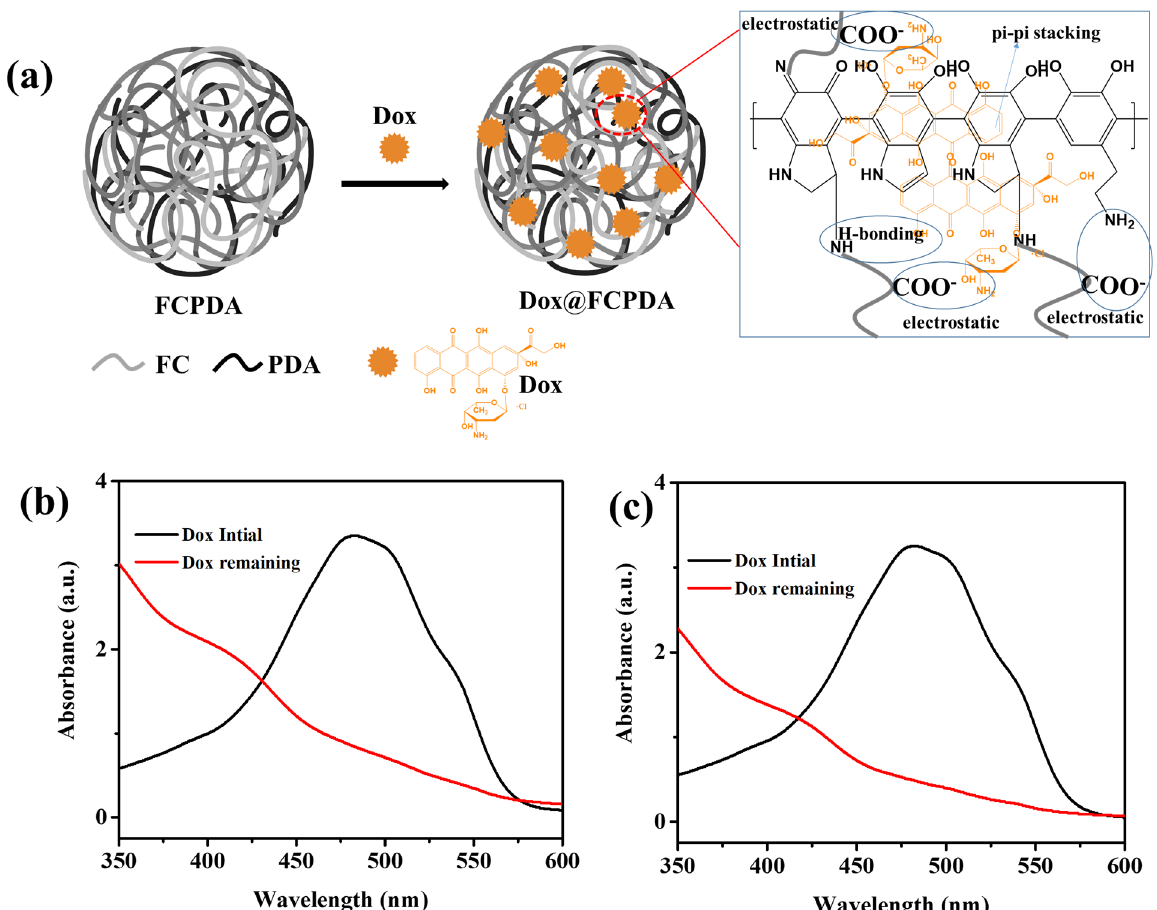
Figure 4. ( a ) Schematic representation of Dox loading to FCPDA nanoparticles and their interactions between Dox and FCPDA nanoparticles, ( b ) UV-Vis absorption spectra of Dox in DDW before and after encapsulation into ( b ) PDA and ( c ) FCPDA nanoparticles.